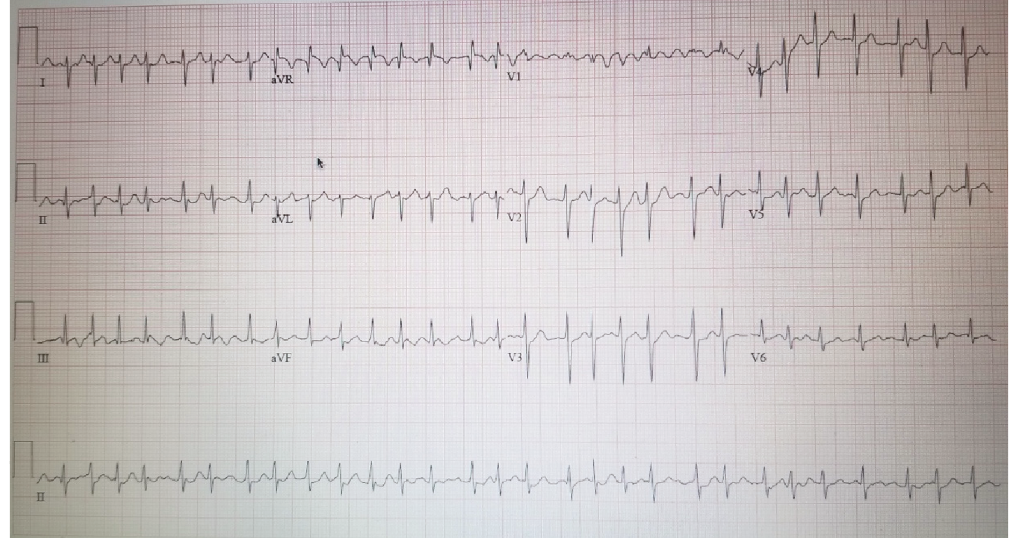
Figure 1: EKG on presentation demonstrating atrial fi brillation with rapid ventricular response.